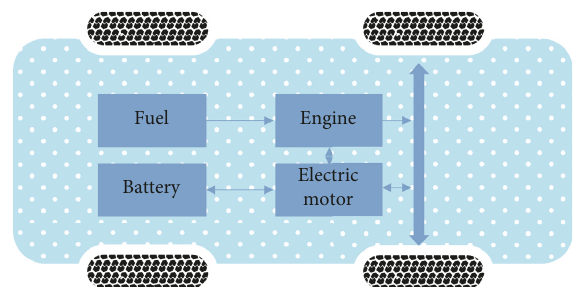
Figure 3: FCEV car